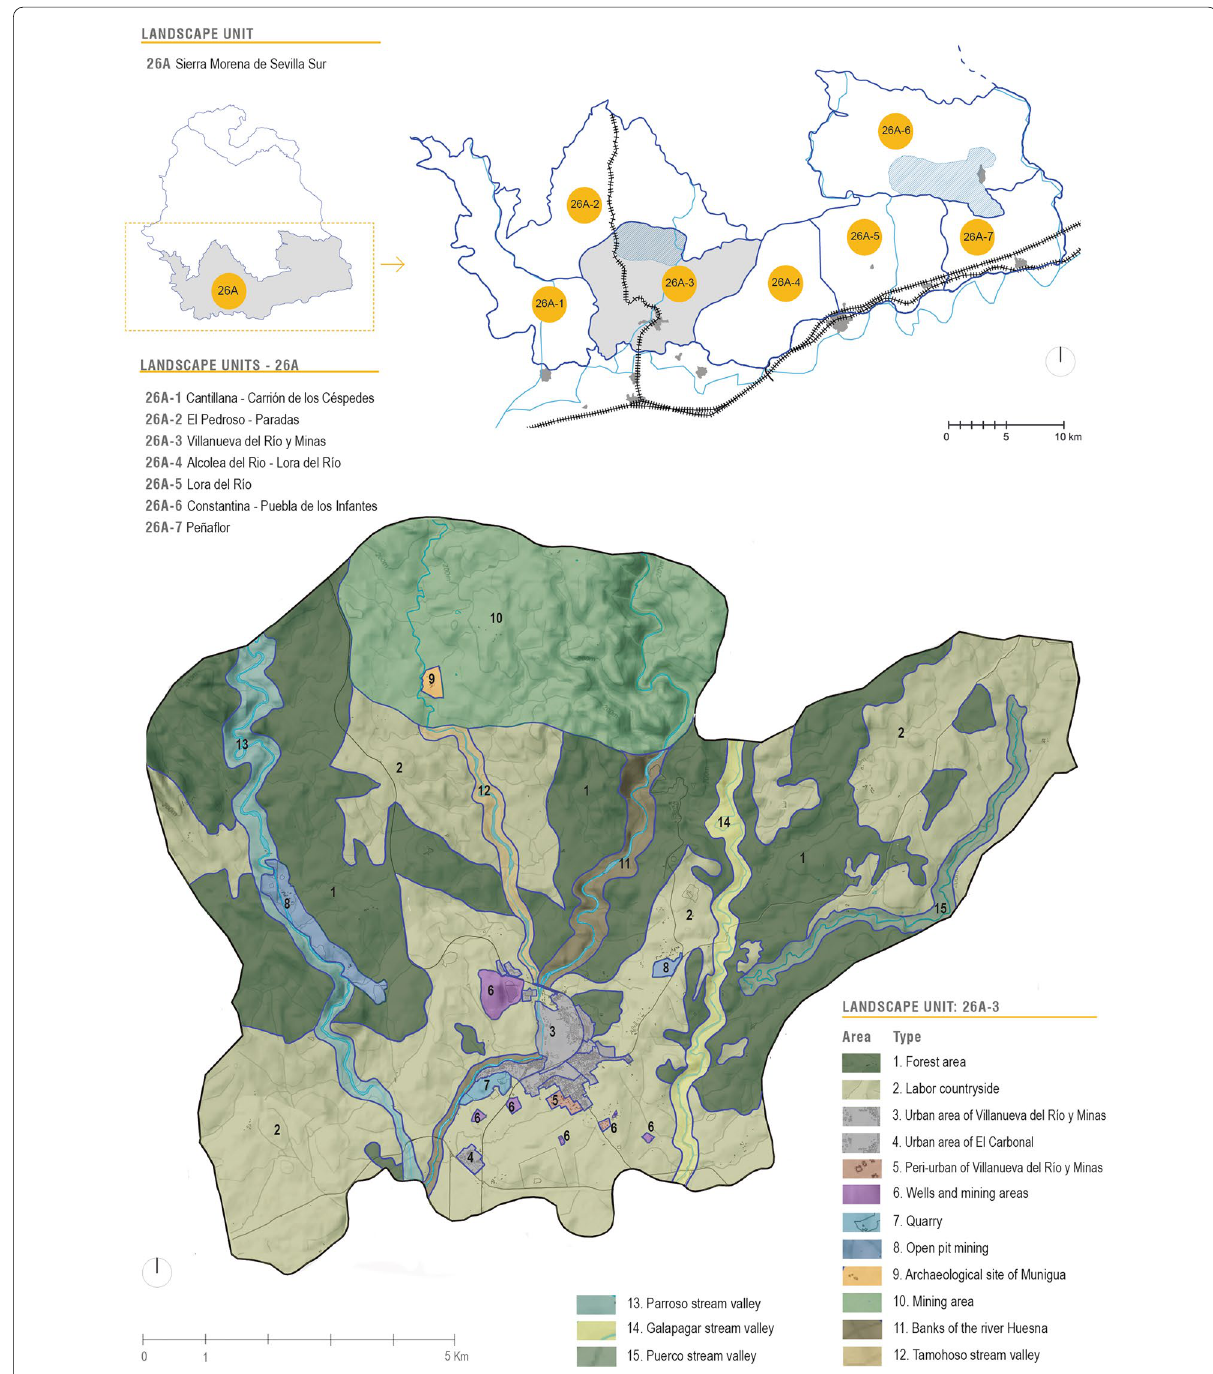
Fig. 3 Identification and delimitation of landscape units at different scales. Source: Own